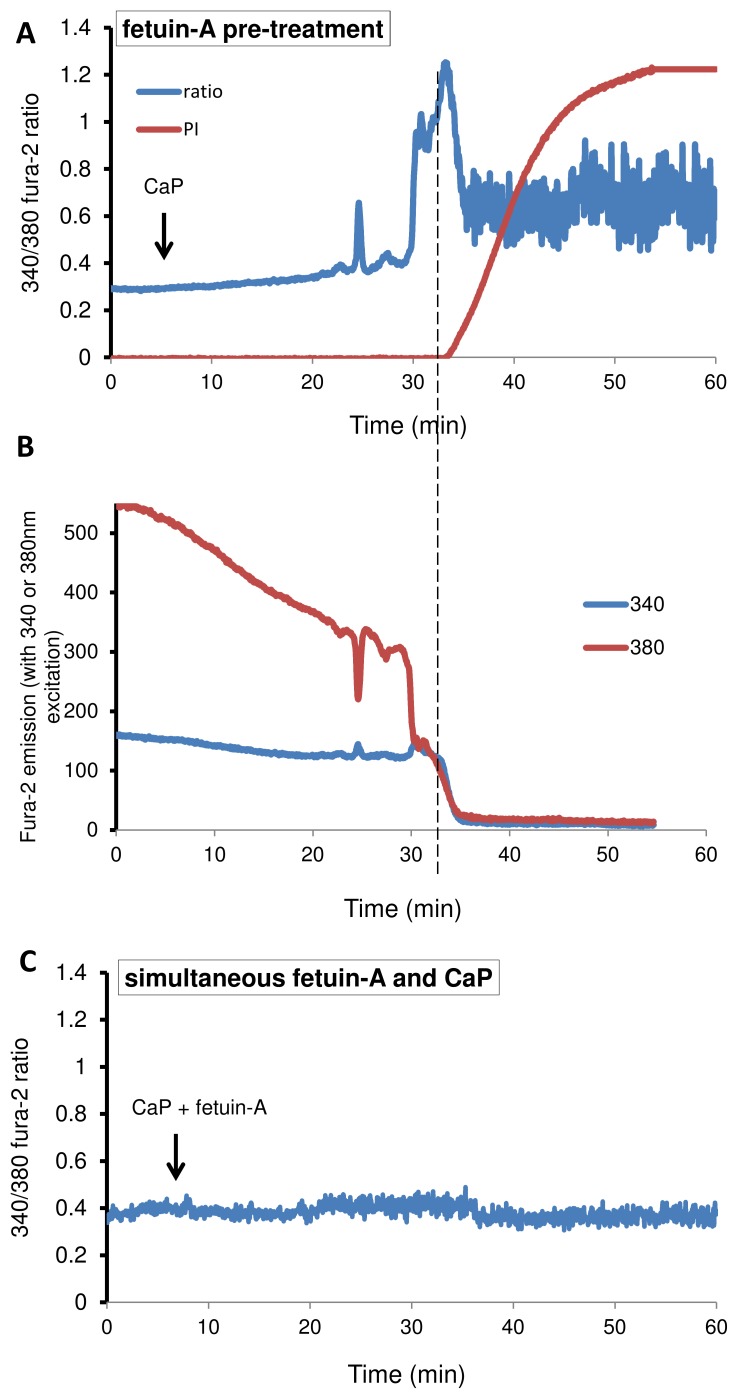
Timing of fetuin-A addition affects the response to CaP particles.Pre-incubating with fetuin-A (1 µM) for 15 minutes followed by replacing cell supernatant with fetuin-A-free physiological buffer gave no protection against cell death on CaP exposure (12.5 µg/mL) (A and B). The ratio of 340/380 fura-2 values is plotted in A and raw data is presented in B, showing that when 340 and 380 nm values both suddenly decline together (fura-2 leak from VSMC), this coincides with PI influx. The Ca2+ activity observed up to the time of fura-2 loss/PI influx represents genuine Ca2+ signals, whereas activity seen after this time point (in A) is not genuine. (C) Simultaneous addition of CaP (12.5 µg/mL) and fetuin-A (1 µM) had very little effect on VSMC intracellular Ca2+ and cells survived over one hour of analysis. Representative traces are shown.